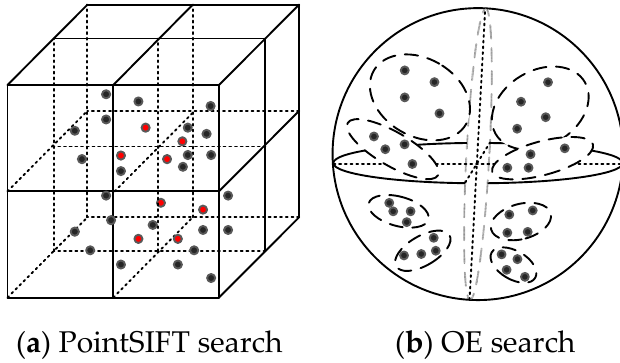
Figure 1. The comparison of PointSIFT and OE convolution.